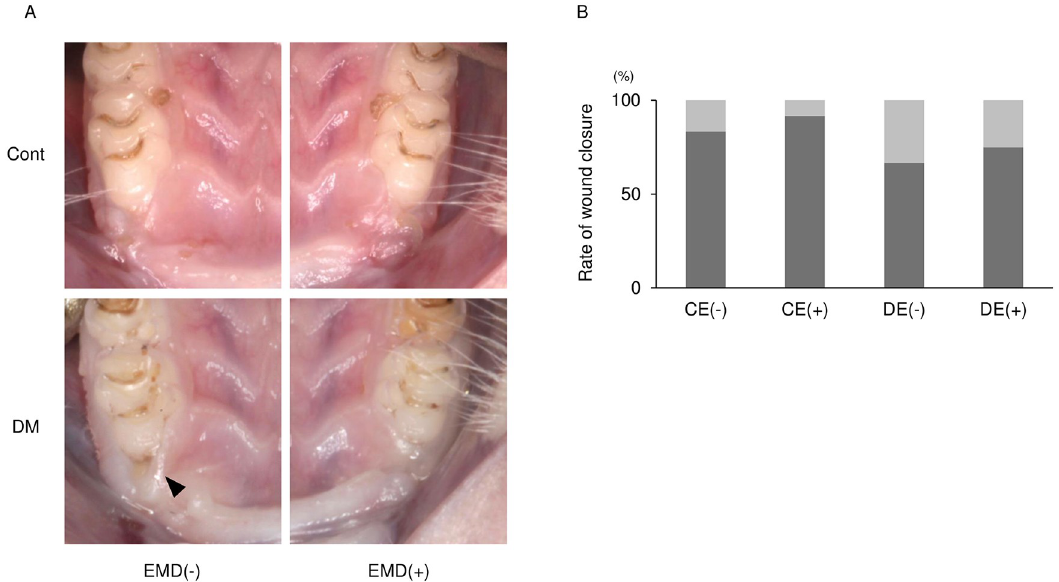
Fig 2. Analysis of postsurgical wound healing. (A) Representative photographs of postsurgical wounds at 7 d after surgery. In the EMD-untreated sites of diabetic rats, wound closure deficiency was observed (arrowheads). (B) Wound closure rates 7 d after surgery among the four groups [control without EMD, CE(-); control with EMD, CE(+); diabetes without EMD, DE(-); and diabetes with EMD, DE(+)]. No statistically significant difference was found between the 4 groups (Fisher’s exact test and binomial test, n =